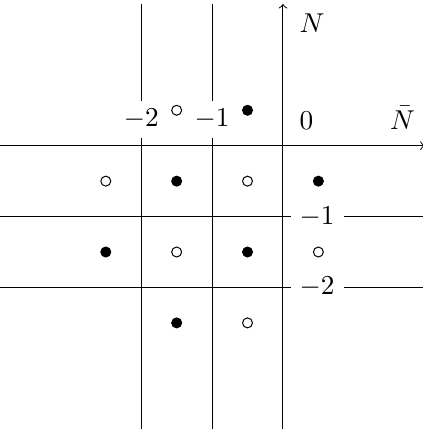
Figure 2 . This figure shows rectangular lattices of sl (2 , C ) weights for two short so (3 , 2) modules: filled circles correspond to i = 3 , j = 2 , while empty circles correspond to i = 2 , j = 3 . Note that both these solutions correspond to the same unordered pair { x 0 , y 0 } = { 2 , 3 } . Note also that thanks to the fact that i + j is odd, values of N and ¯ N in this module are half-integer and, as a result, special points are